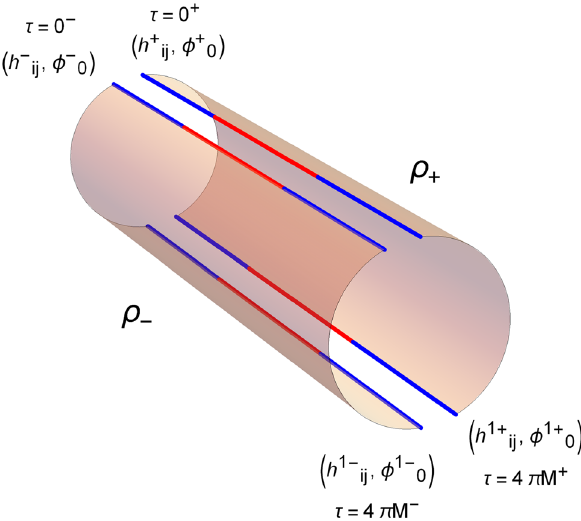
Fig. 13 Representation of the manifolds associated to ρ − and ρ +